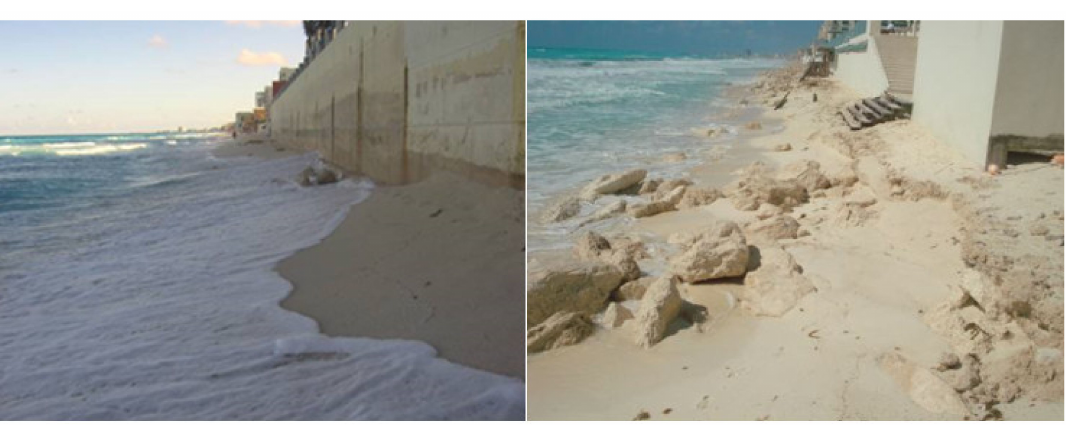
Figure 8. View of the beach at Cancun in 2009, before the second nourishment. Waves attacking the hotel facings (left) and rocks left behind after erosion (right).